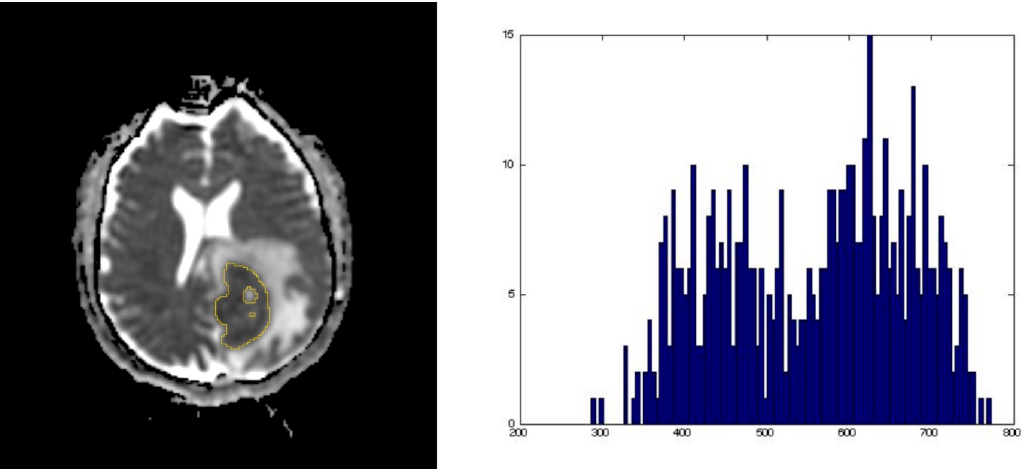
Figure 1. Representative images of an apparent diffusion coefficient (ADC) map whole tumor segmentation with its corresponding ADC histogram distribution used for data analysis.